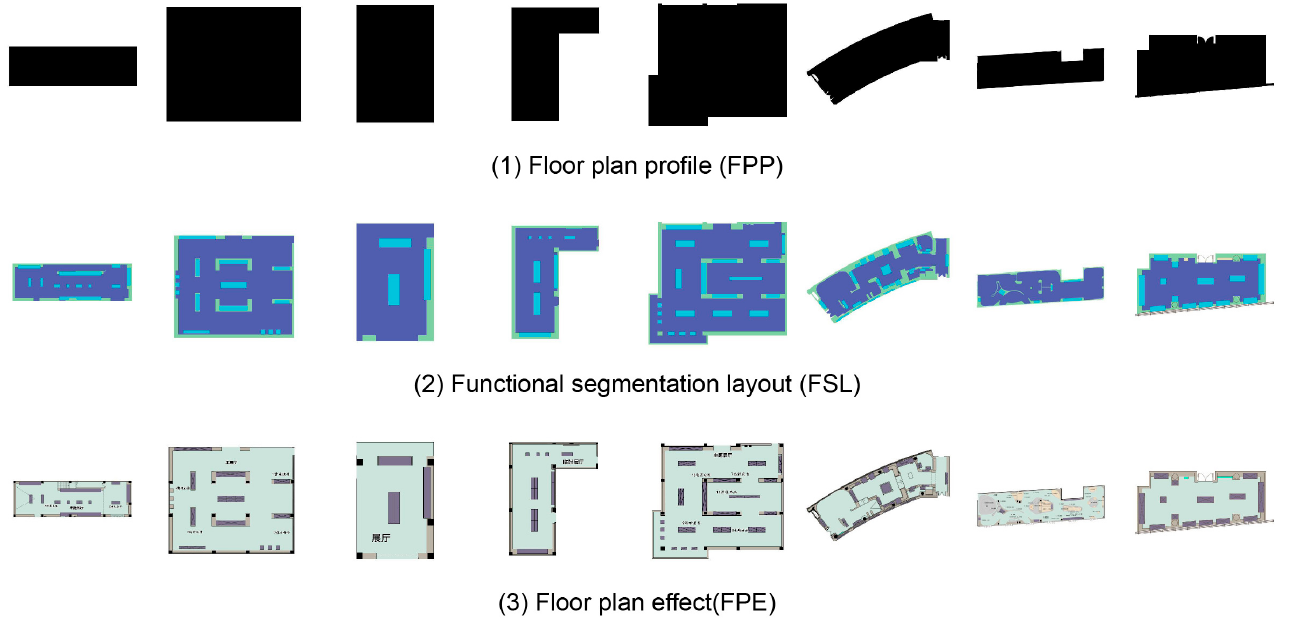
Figure 2. Materials used in this study. ( 1 ) Floor plan profile (FPP); ( 2 ) Functional segmentation layout (FSL); ( 3 ) Floor plan effect (FPE), and the Chinese annotations in the floor plan represent its spatial function.